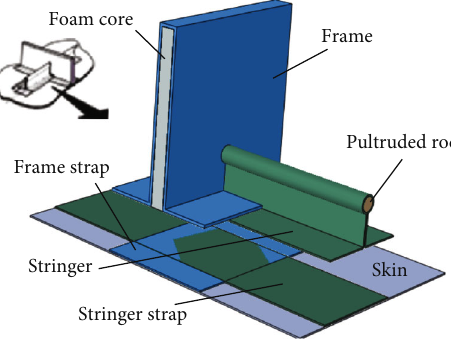
Figure 1: PRSEUS panel ’ s general